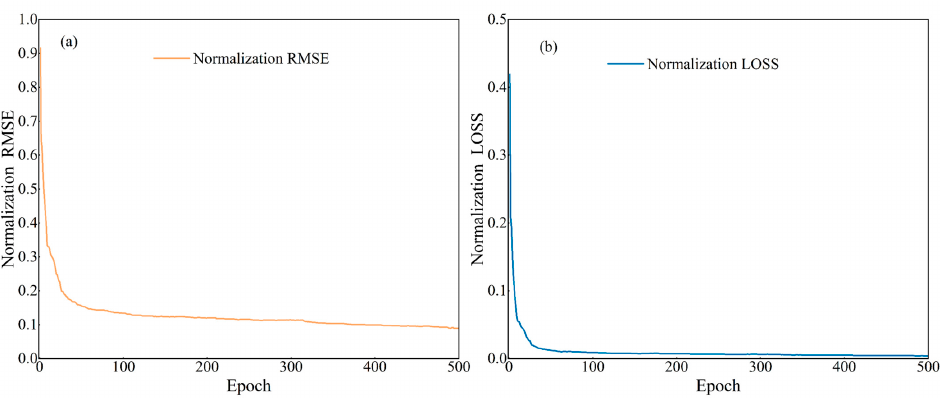
Figure 8. The training period results of LSTM model at Pochengzi hydrological station. ( a ) normal- ized RMSE and ( b ) normalized loss function.